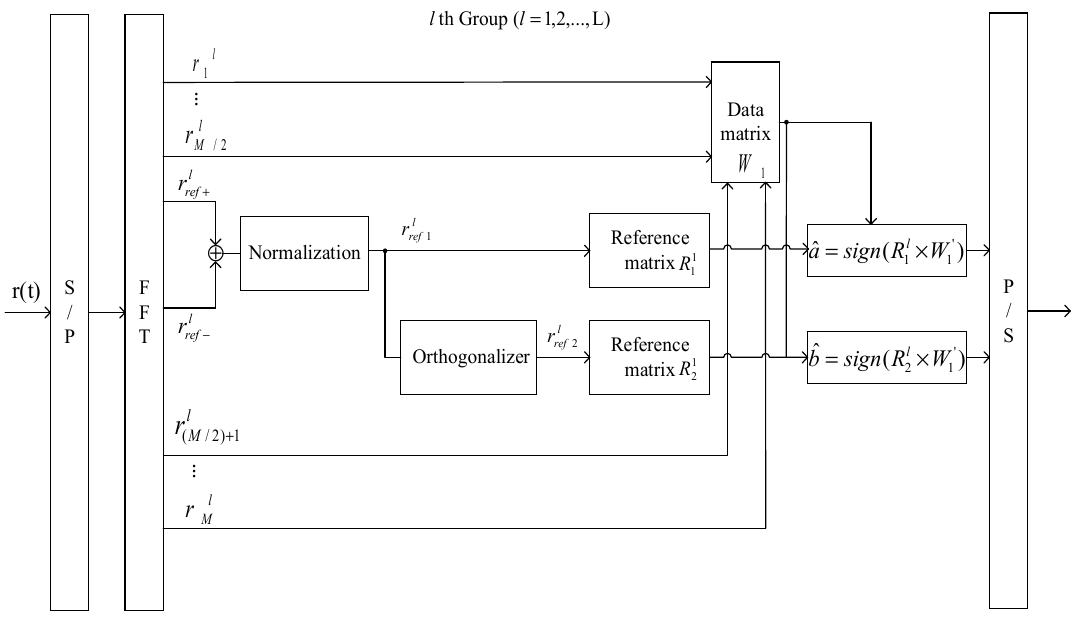
Figure 6. Receiver of MC − ODBR − DCSK.